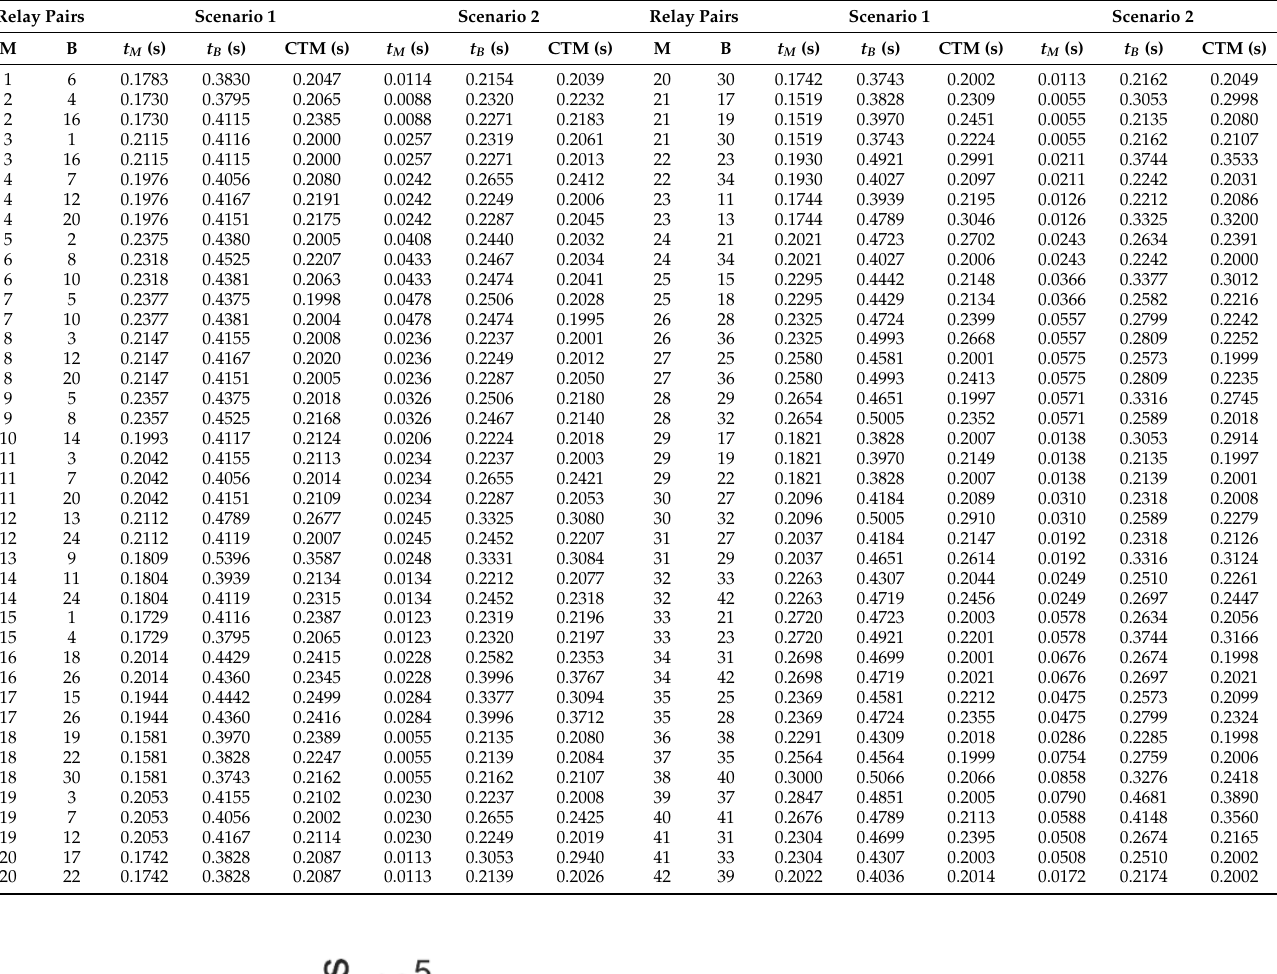
Table 3. Operating times of M/B relay pairs with their associated CTM values of the IEEE 15-bus based on GTO.